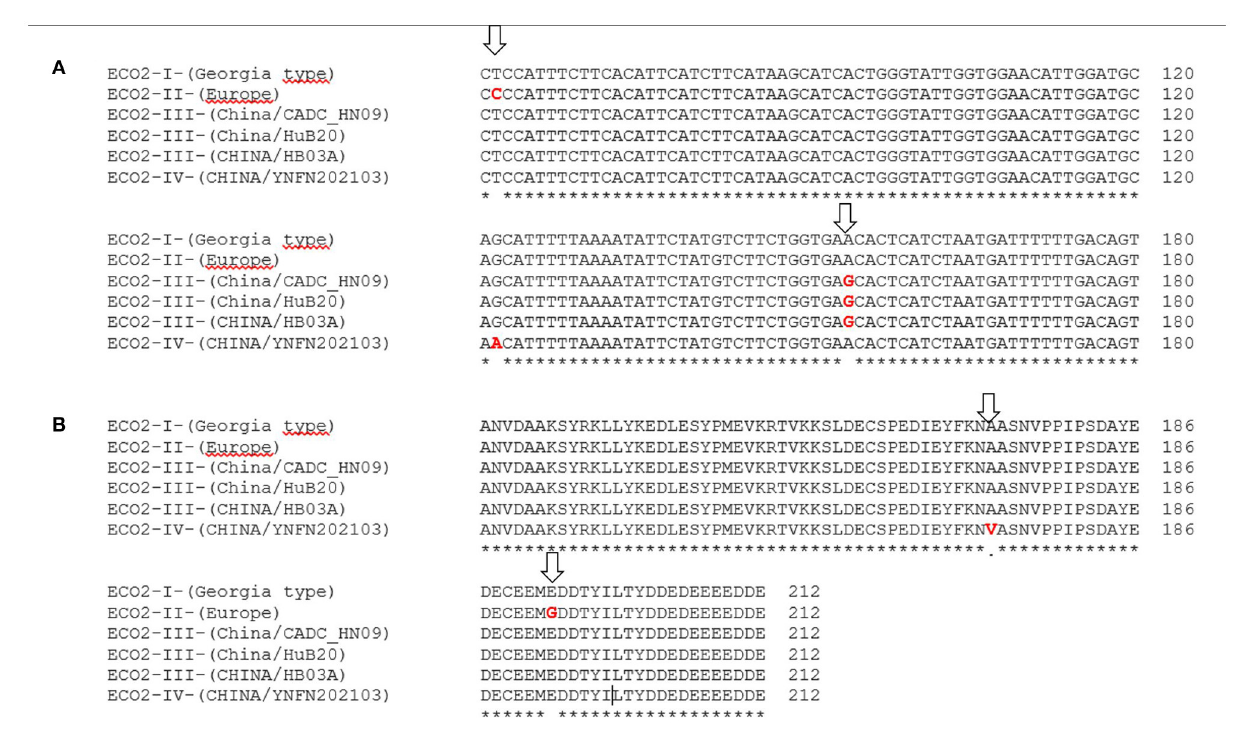
FIGURE4 (A) Partial nucleotide sequence alignment and (B) amino acid alignment of the SNPs identified in the I215L gene amplified using the primers ECO2A/2B. In red are showed the variations marked with